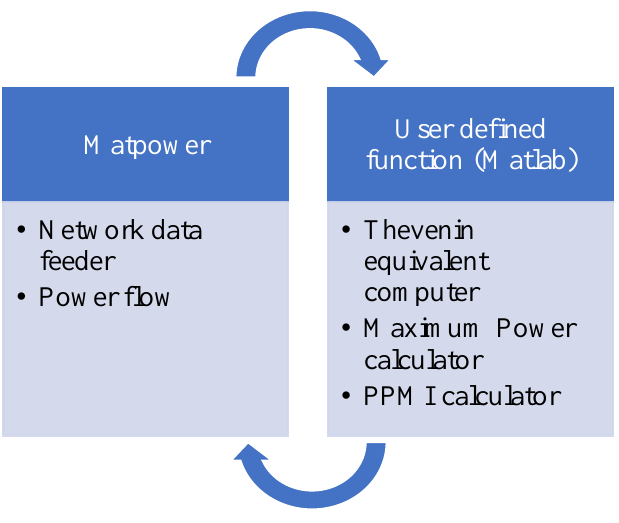
Figure 3. The interaction of the software employed and the developed functions for the simulation The simulation is performed in the following procedure.